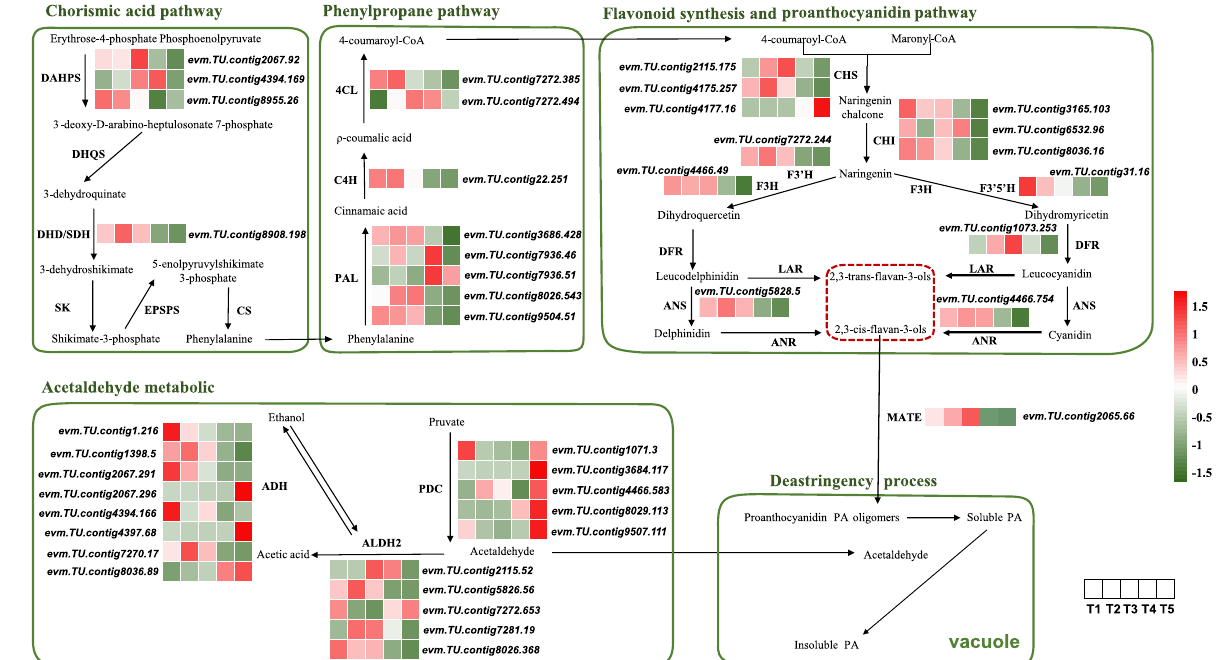
Figure 4. Expression patterns of 43 DEGs involved in PA biosynthesis and insolubilization. PA biosynthesis pathways include the chorismic acid pathway, phenylpropane pathway, flavonoid synthesis and proanthocyanidin-specific pathway. PA insolubilization refers to converting soluble PA into insoluble PA with acetaldehyde metabolism. Heatmaps depict the normalized gene expression values, which represent the mean value of three biological